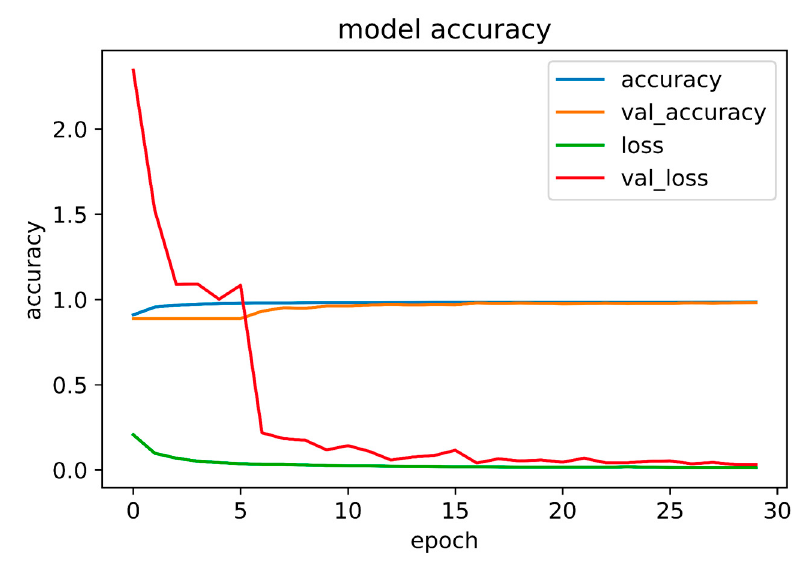
Figure 4. Accuracy of the PBL boundary detection model.